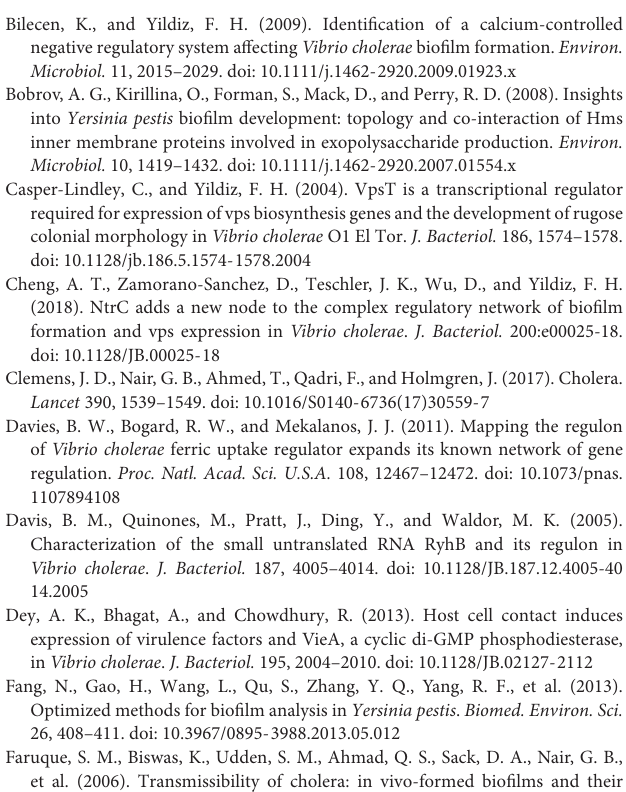
Supplementary Figure 1 | Cell density-dependent expression of Fur. The promoter-proximal DNA region of fur was cloned into the pBBRlux vector and transferred into WT to determine the luminescence activity under various OD 600 values. The bacteria were cultivated at 30 ◦ C in LB broth with DP or iron supplementation. Supplementary Figure 2 | Transcription start sites for cdgD , vpsA , and vpsU . Negative numbers represent nucleotide positions upstream of the translation start site for each target gene. The transcription start sites are marked with asterisks and positions. The boxed sequences indicated the sequences of Adaptor. Supplementary Table 1 | Oligonucleotide primers used in this study. Supplementary Table 2 | Predicted Fur box-like sequences within target